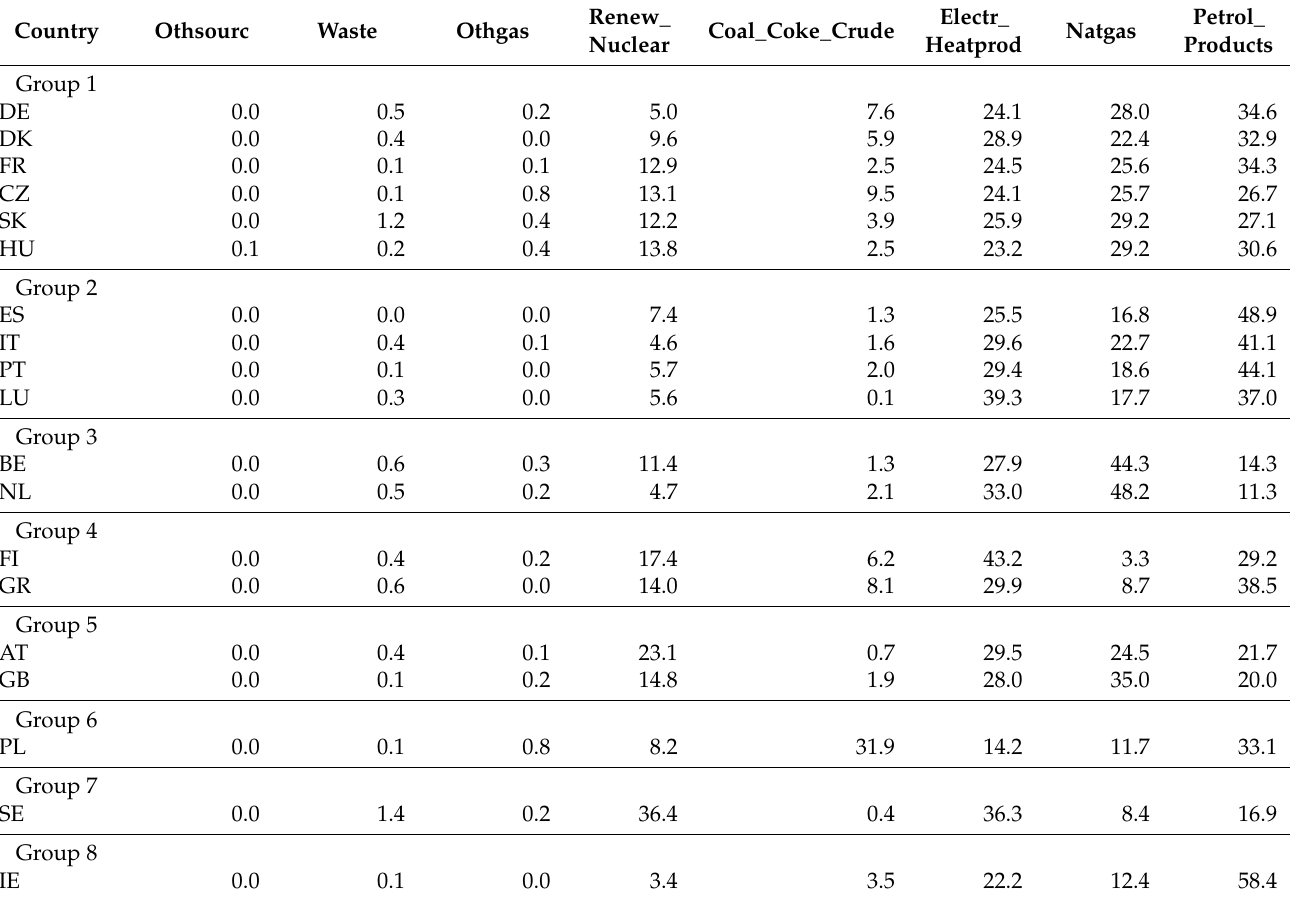
Table 2. Structures of energy use (%) in the food production systems in 2015–2016 ( γ = 0.18).